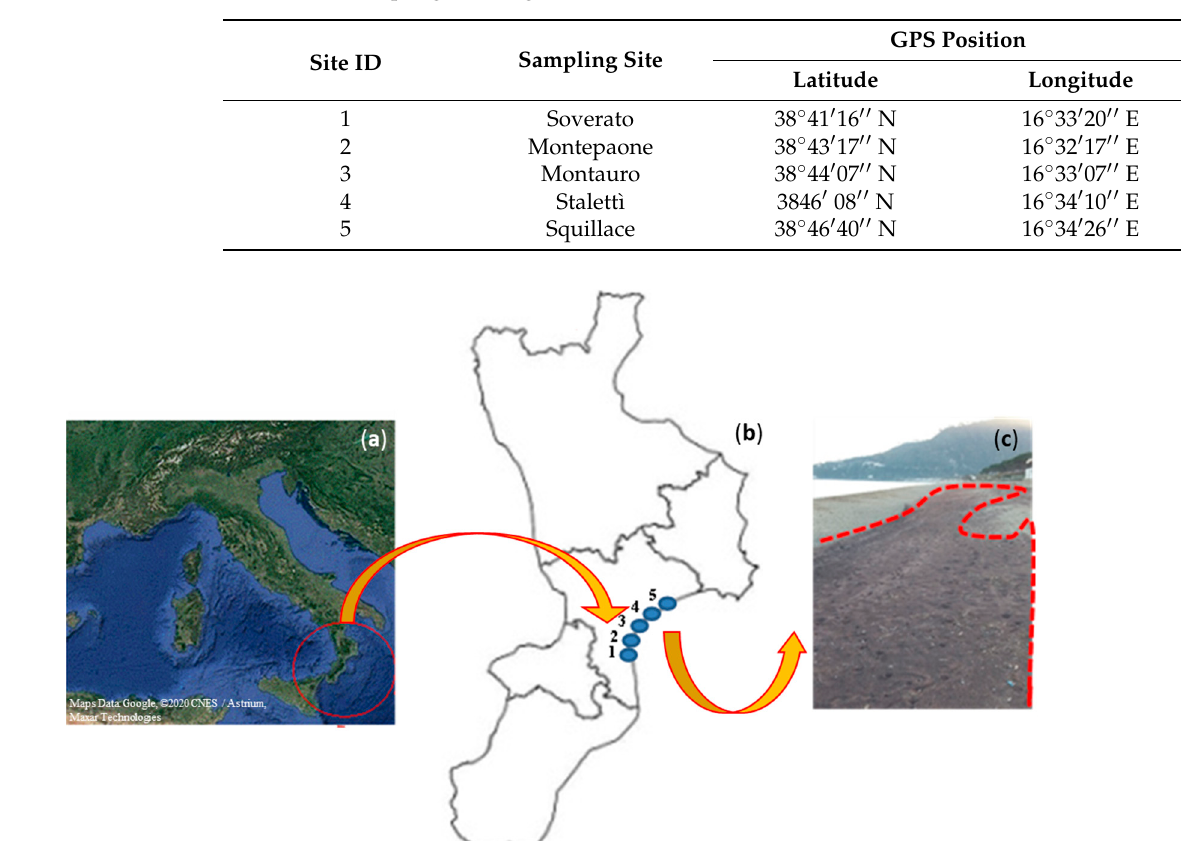
Table 1. The sampling sites, together with their IDs and GPS coordinates.